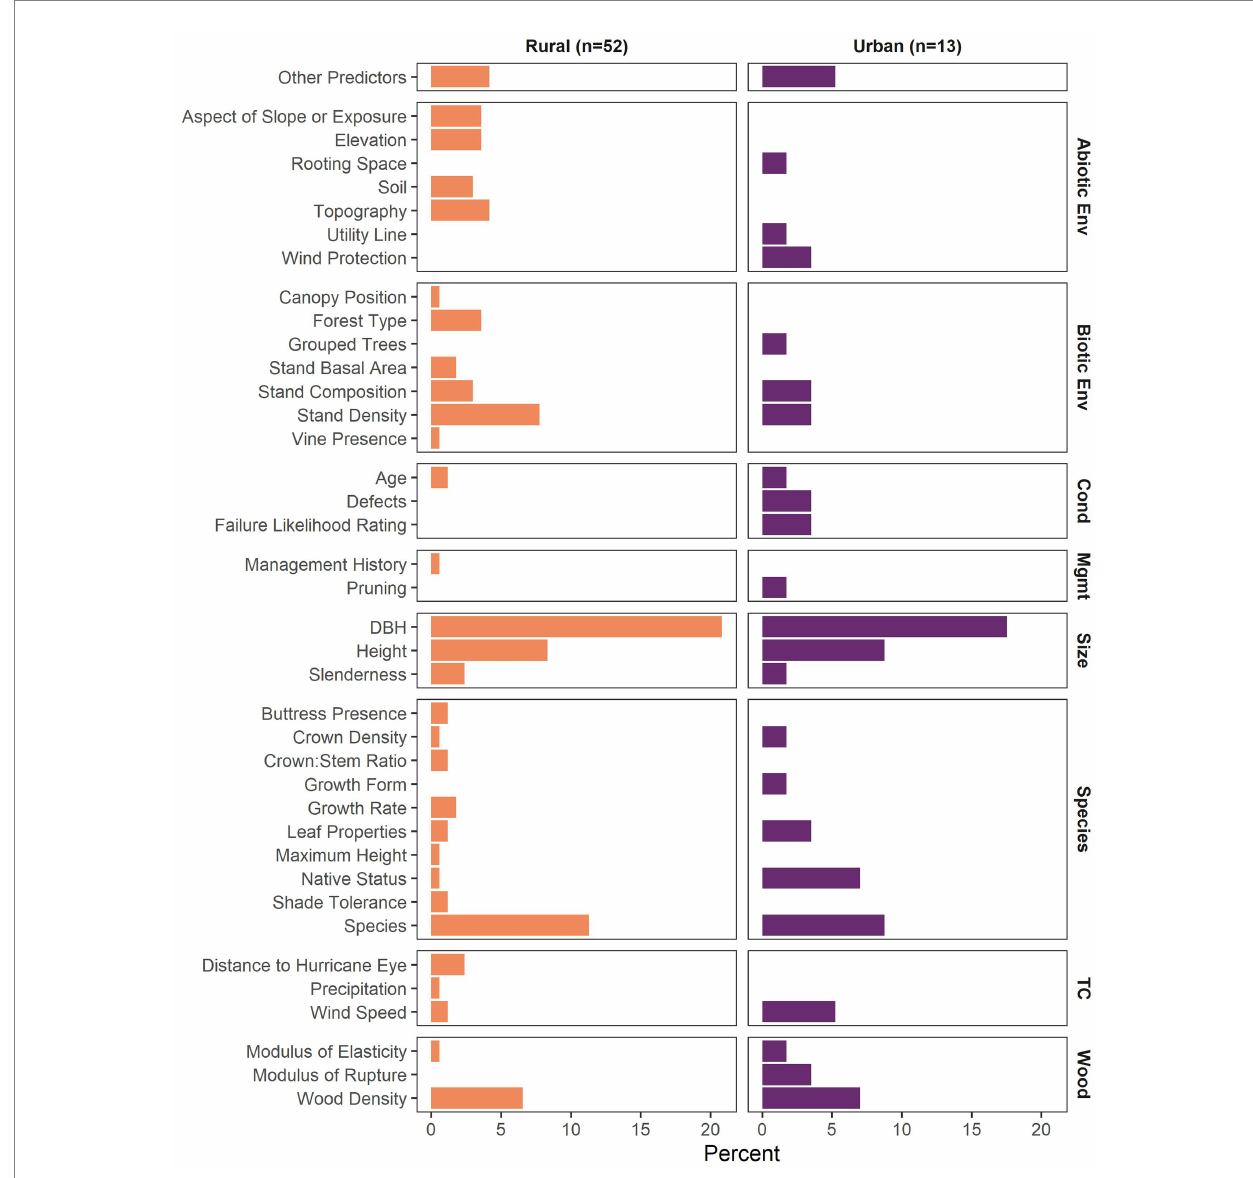
FIGURE 6 The frequency of each type of predictor examined in the studies identified by the literature review. Data are presented as a percentage of the total number of rural or urban studies and are grouped by theme. Categories with no bar were not analyzed by any urban or rural study. Denominator = number of urban or rural studies. Cond, condition; Env, environment; Mgmt, management; TC, tropical cyclone. Categories included in “Other Predictors” are listed in Table